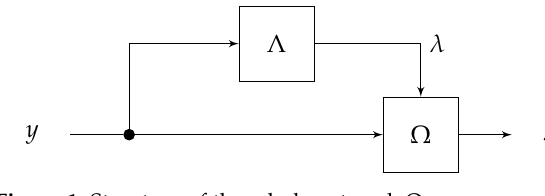
Figure 1. Structure of the whole network Θ .